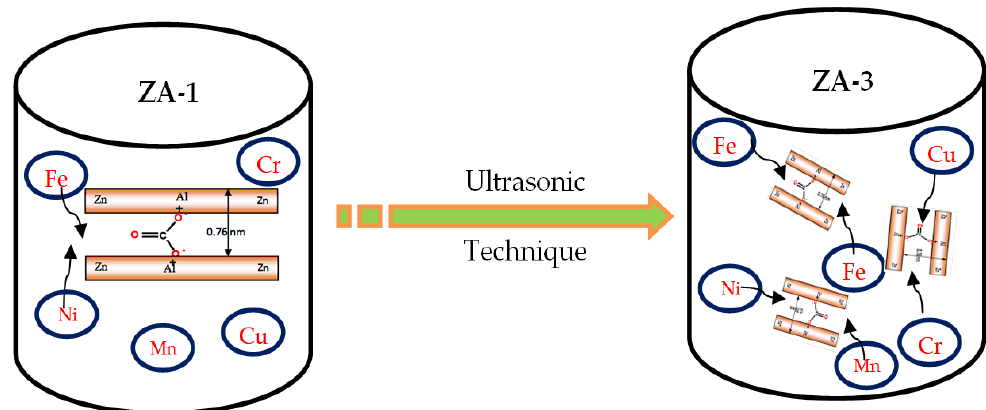
Figure 6. Adsorption process for purifying water from heavy metals at an extremely acidic medium for sample ZA-3 compared with standard sample ZA-1.